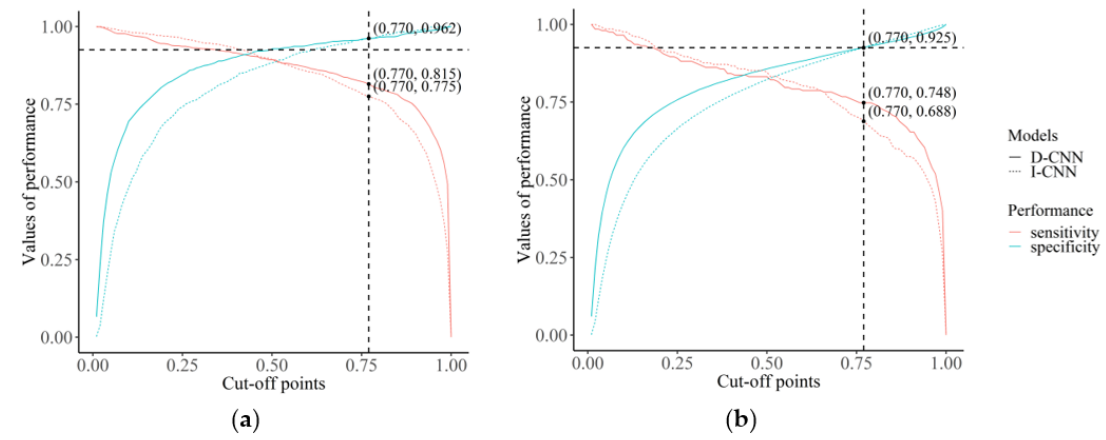
Figure 3. Value of sensitivity and specificity changed according to the cut-off point: ( a ) the sensitivity and specificity for the training data set and ( b ) the sensitivity and specificity for the test data set.